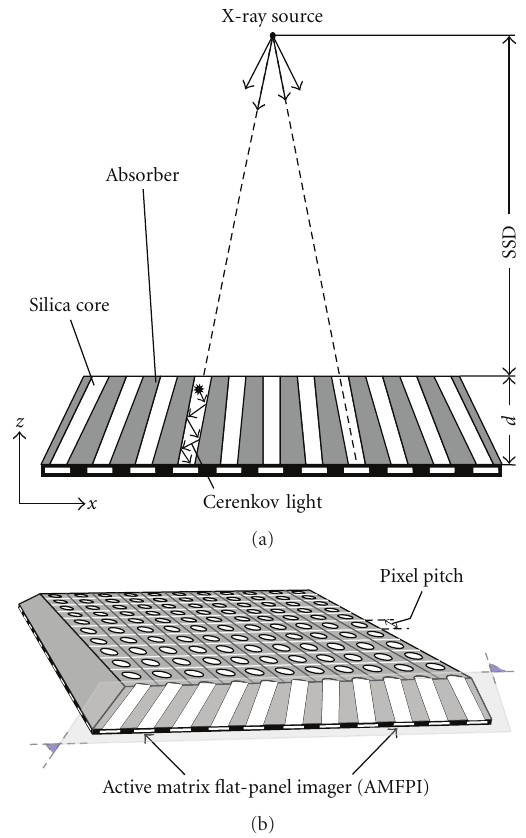
Figure 1: Schematic illustration of the proposed CPID. (a) a small cross section of the detector and (b) a 3D view of a small portion of the detector. The detector contains 931 × 931 pixels in the actual